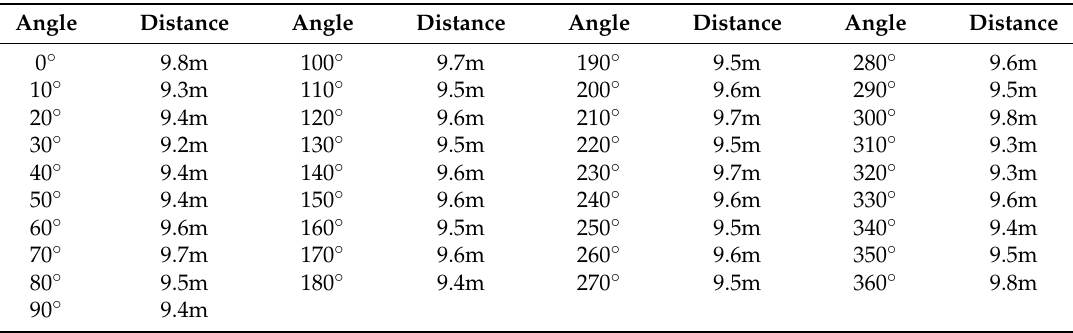
Figure 13. Experiment environment of recognition range. Table 9. Test result of recognition